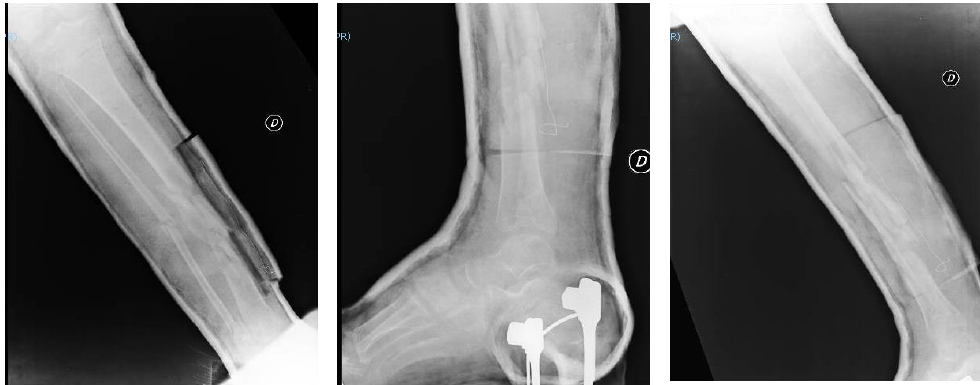
Figure 6. Radiograph of the right leg and ankle after the new treatment performed in October 2016, including the removal of the external fixator and packaging of the pin-femoral-podalic appliance incorporating a trans-calcaneal traction bracket.